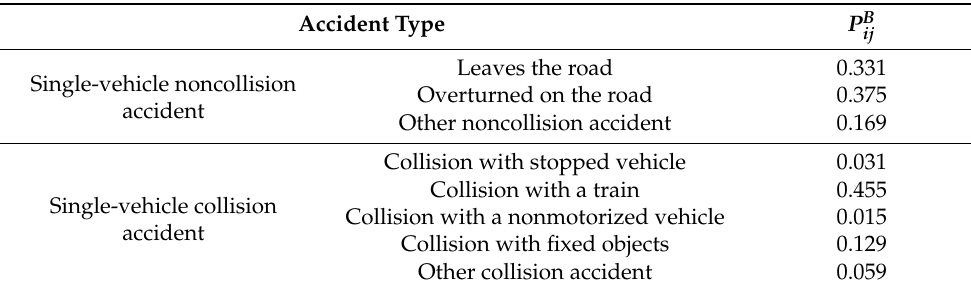
Table 2. Leakage accident probability under certain